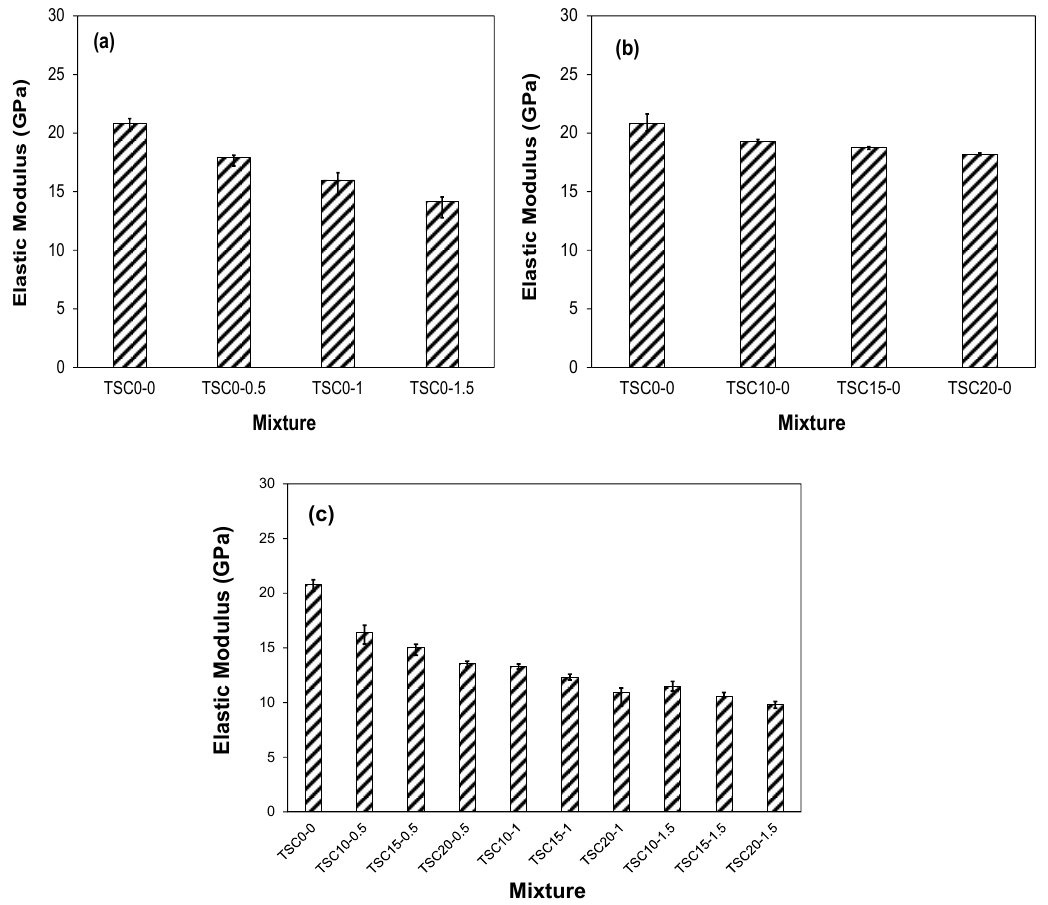
Figure 6. Elastic modulus of di ff erent TSC specimens: ( a ) steel wire, ( b ) tire rubber, and ( c ) combined steel wire and tire rubber.